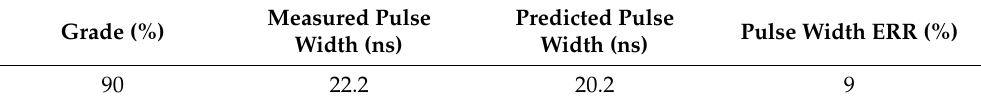
Table 5. The ERR of half width between measurement and prediction of 3 MHz.